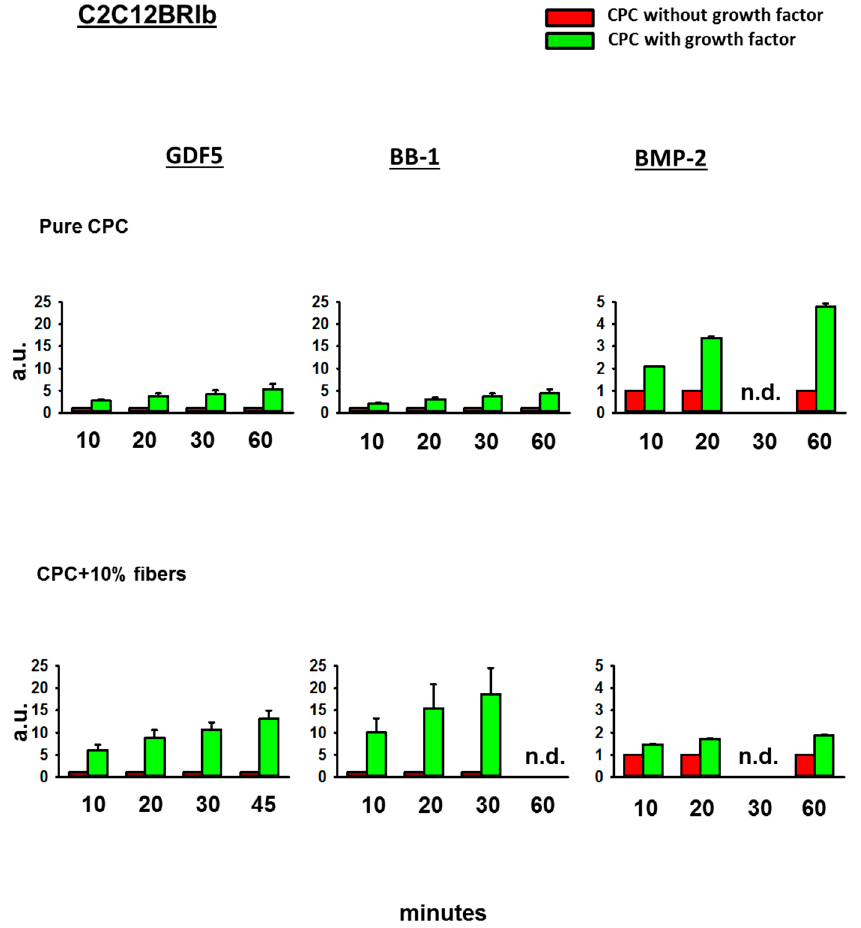
Figure 5. Alkaline phosphatase (ALP) activity in C2C12BRIb cells. C2C12BRIb cells were cultivated for 3 days in diluted extracts of GDF5, BB-1, or BMP-2-containing, ground pure CPC or PLGA fiber-reinforced CPC. Thereafter, the ALP activity was measured using an ALP assay and the data were expressed as fold-change induction compared to the CPC without growth factor; data are expressed as means ± SEM ( n = 3); n.d. = not determined; a.u. = arbitrary units.